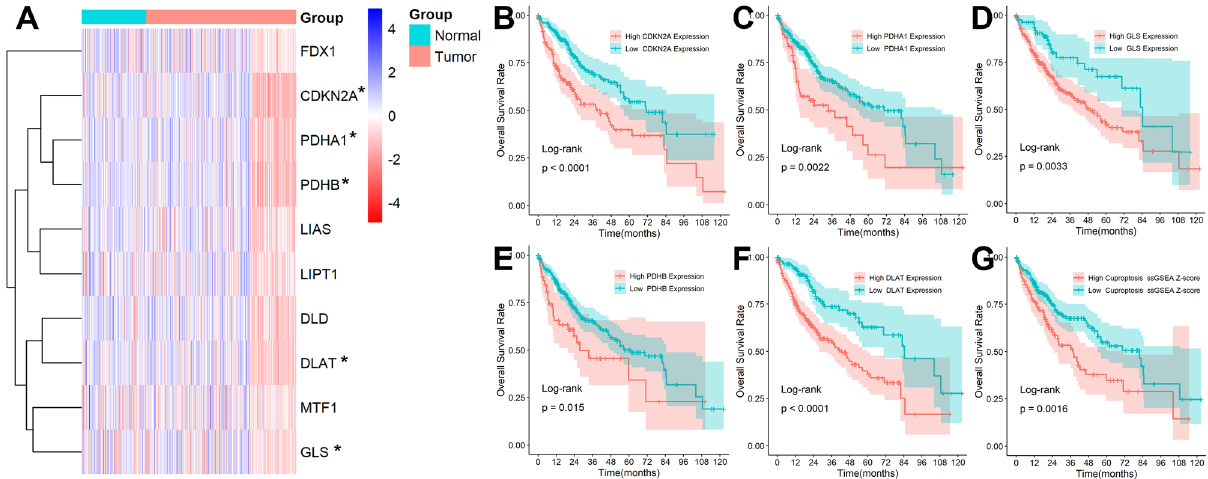
Figure 1. Expression of Cuproptosis-associated Genes in HCC. ( A ) Expression levels of ten genes in normal tissues and HCC. A prognostic value analysis of CDKN2A ( B ), PDHA1 ( C ), GLS ( D ), PDHB ( E ), DLAT ( F ), and Cuproptosis Z-scores ( G